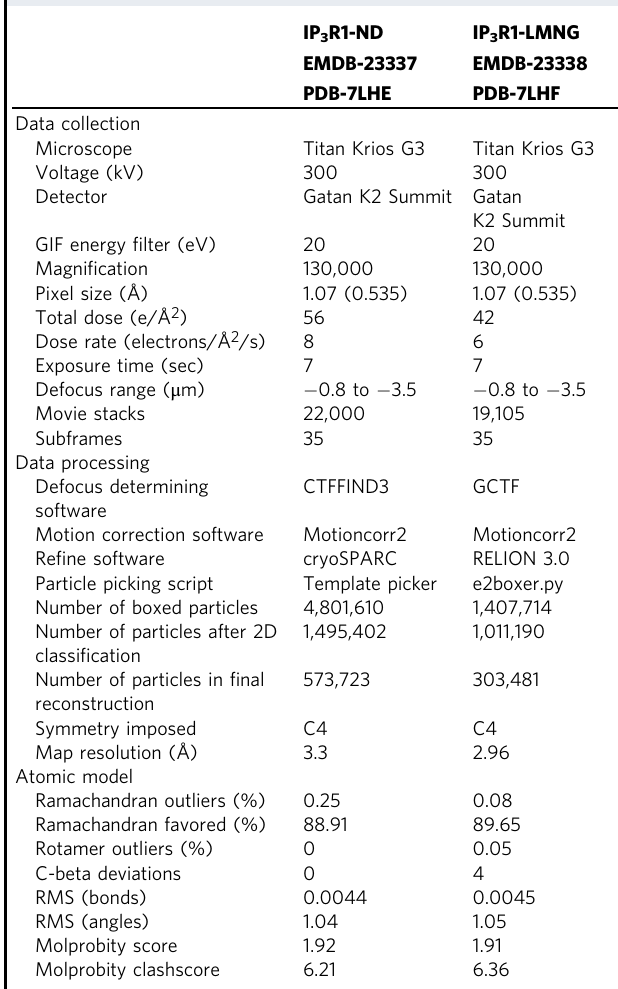
Table 1 Cryo-EM structure determination and model